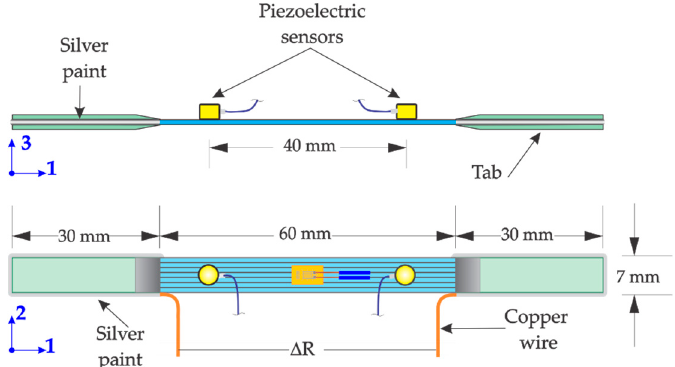
Figure 3. Tensile test specimen dimensions and instrumentation for in situ electrical monitoring coupled with acoustic emission.